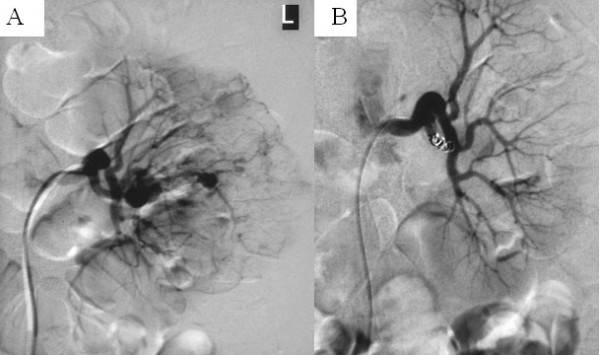
Angiography of spontaneous perirenal haemorrhage. A, Pre-embolisation. B, Post-embolisation of a branch of renal artery.